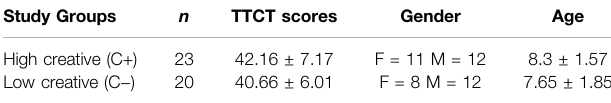
TABLE 4 | Study groups for WeDo Construction